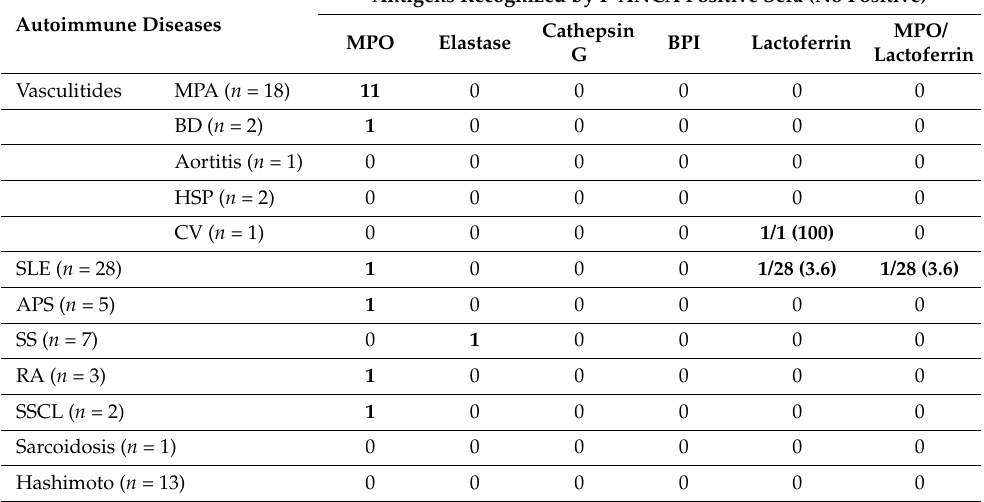
Table 2. P-ANCA-related antigenic specificities in the various P-ANCA-positive autoimmune disease patients